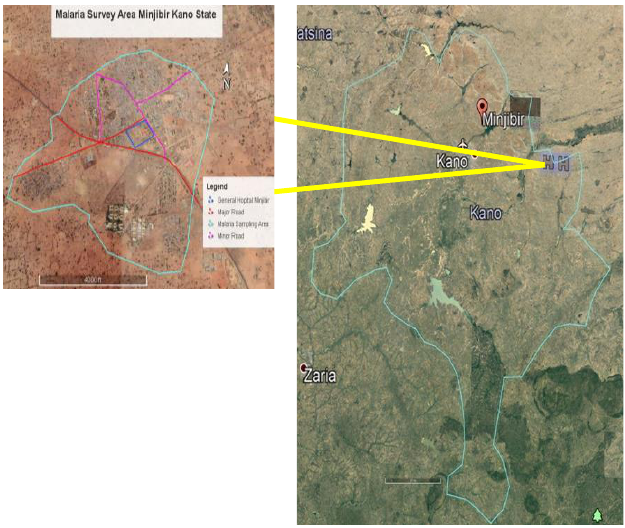
Figure 3: Illustrates the 3 graphical models in Pie form showing cases of